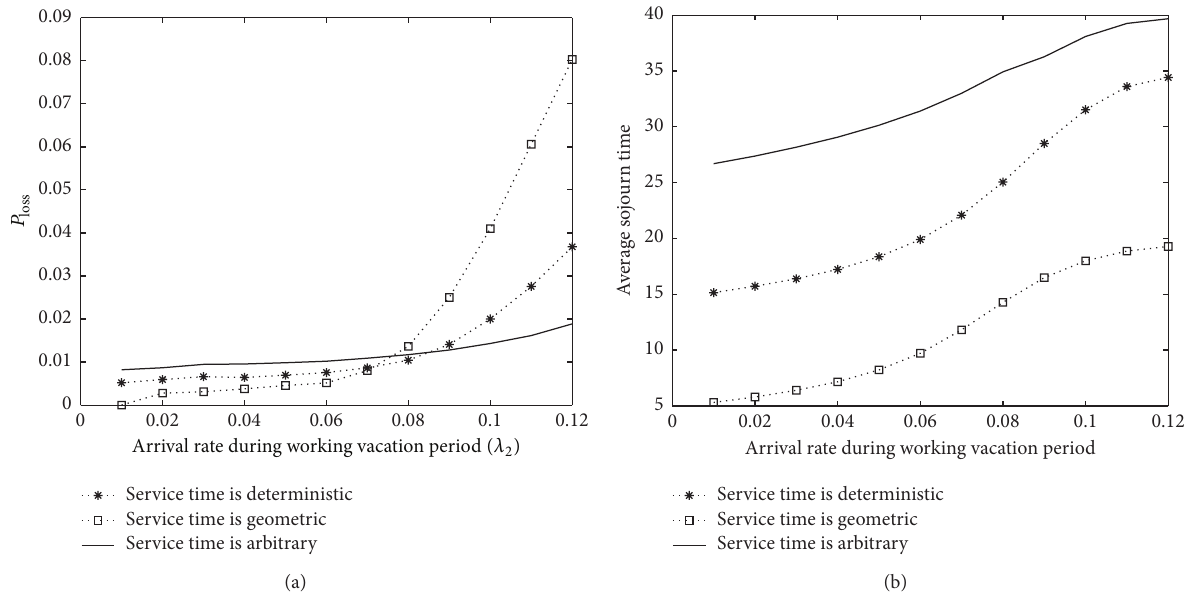
Figure 4: (a) Effect of 𝜆 2 on blocking probability under different service time distributions. (b) Effect of 𝜆 2 on average sojourn time under different service time